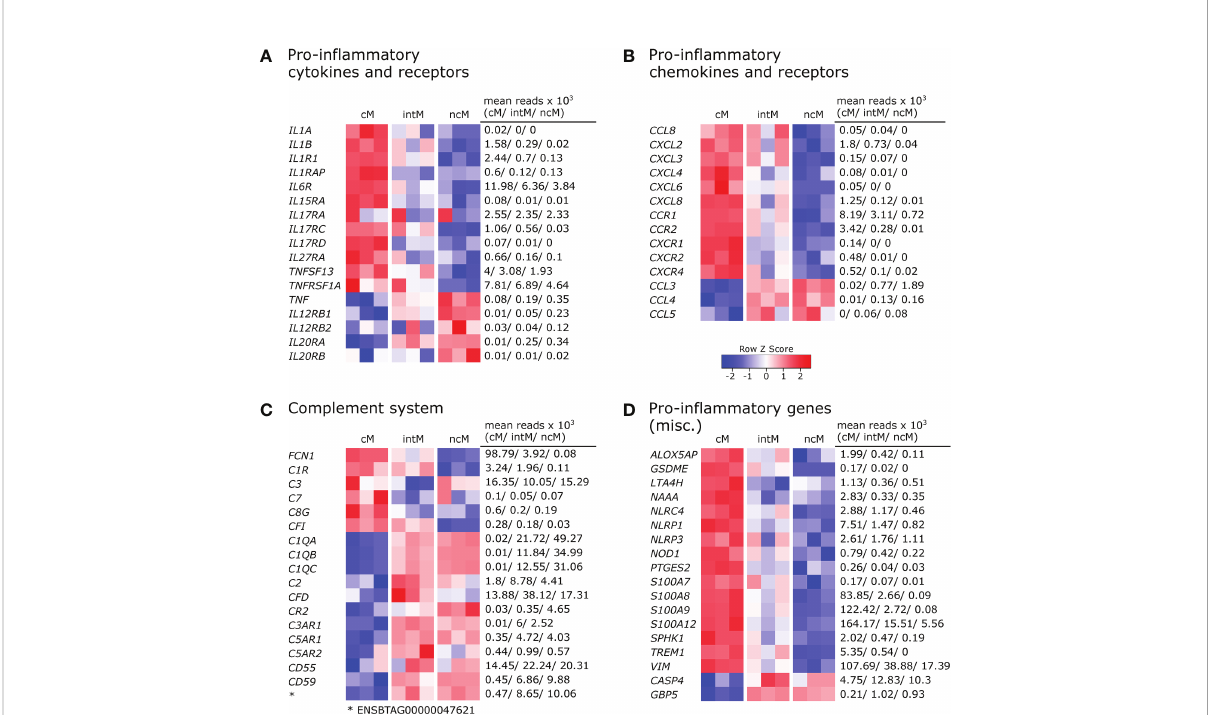
FIGURE 2 Pro-in fl ammatory gene expression. Illumina sequencing was performed on RNA isolated from sorted monocyte subsets (cM, intM, ncM) of three animals. Heatmaps show row z-scores calculated from log2-transformed normalized counts of selected genes coding for pro-in fl ammatory cytokines and receptors (A) , pro-in fl ammatory chemokines and receptors (B) , proteins associated with the complement system (C) , and other pro-in fl ammatory mediators (D) . Mean kilo reads for each subset and gene are given to the right of each heatmap. Genes were selected based on pairwise comparisons with DESeq2 (adjusted p-value < 0.05) and literature